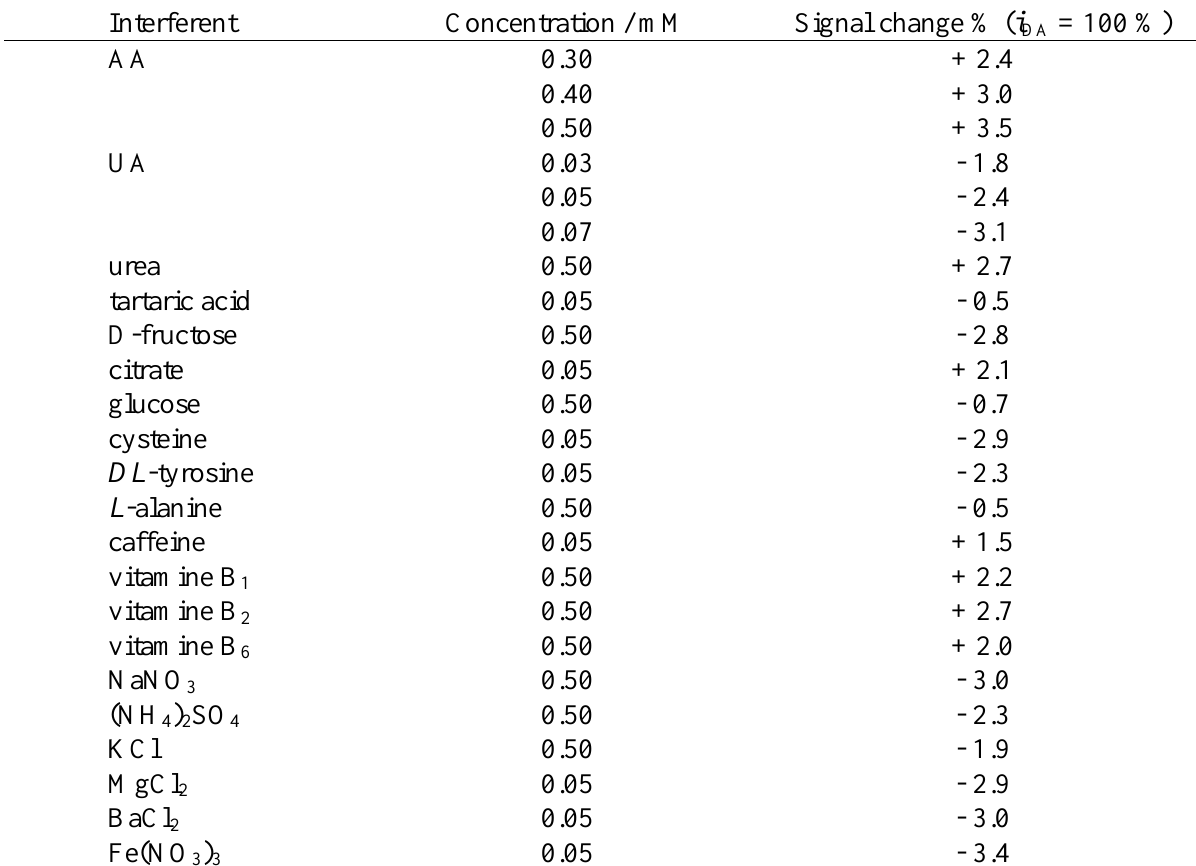
Table 1. Influence of potential interferents on the voltammetric response of 0.5 µM